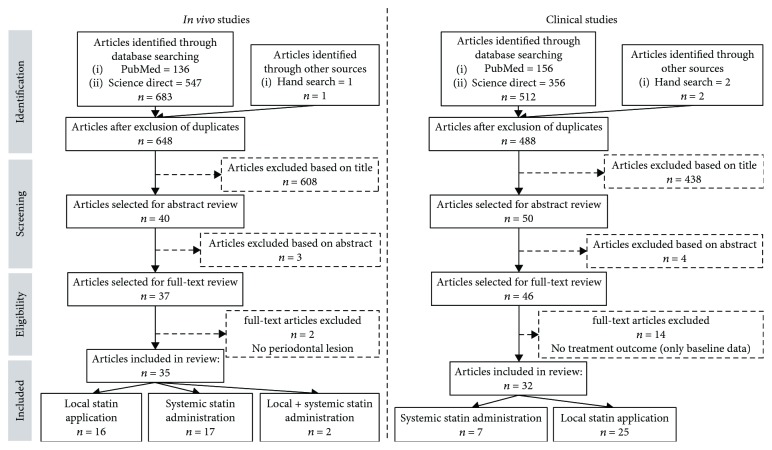
Selection of the studies.